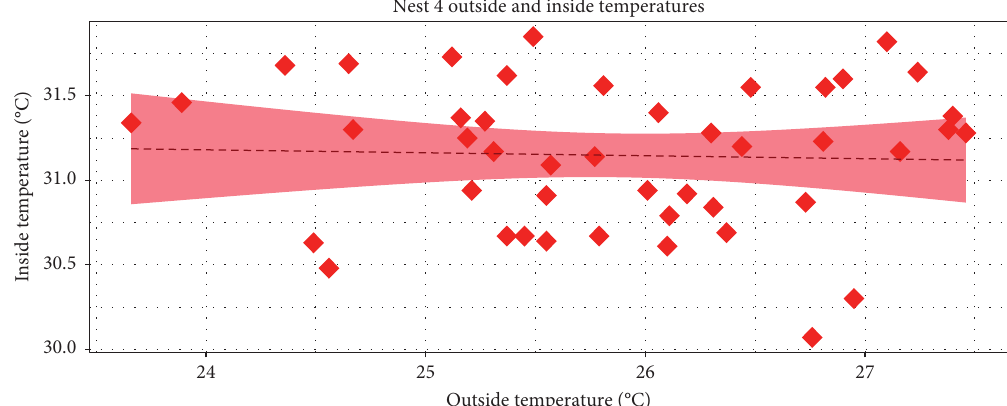
Figure 4: Correlation of nest 4 mean daily incubation temperature and mean daily ambient temperature.